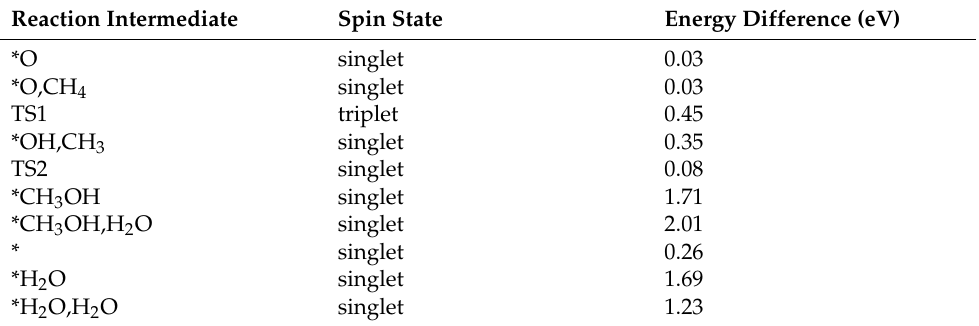
Figure 4. Coverages calculated for the reaction over four different sites: Z 2 [Cu 2 O] in ZSM-5, Z 2 [Cu 2 O]H 2 O in SSZ-13, Z 2 [Cu 2 O] in SSZ-13 and Z 2 [Cu 2 OH] in SSZ-13. ( a ) shows transient kinetics and the fraction of empty sits as a function of time at a fixed temperature of 523 K. In ( b ), the half-time of the sites as a function of temperature is shown. Table 2. Spin states of the intermediates in the reaction over Z 2 [Cu 2 O] following the reaction mechanisms in Figure 2. The energy difference presented is that between the two lowest spin states in